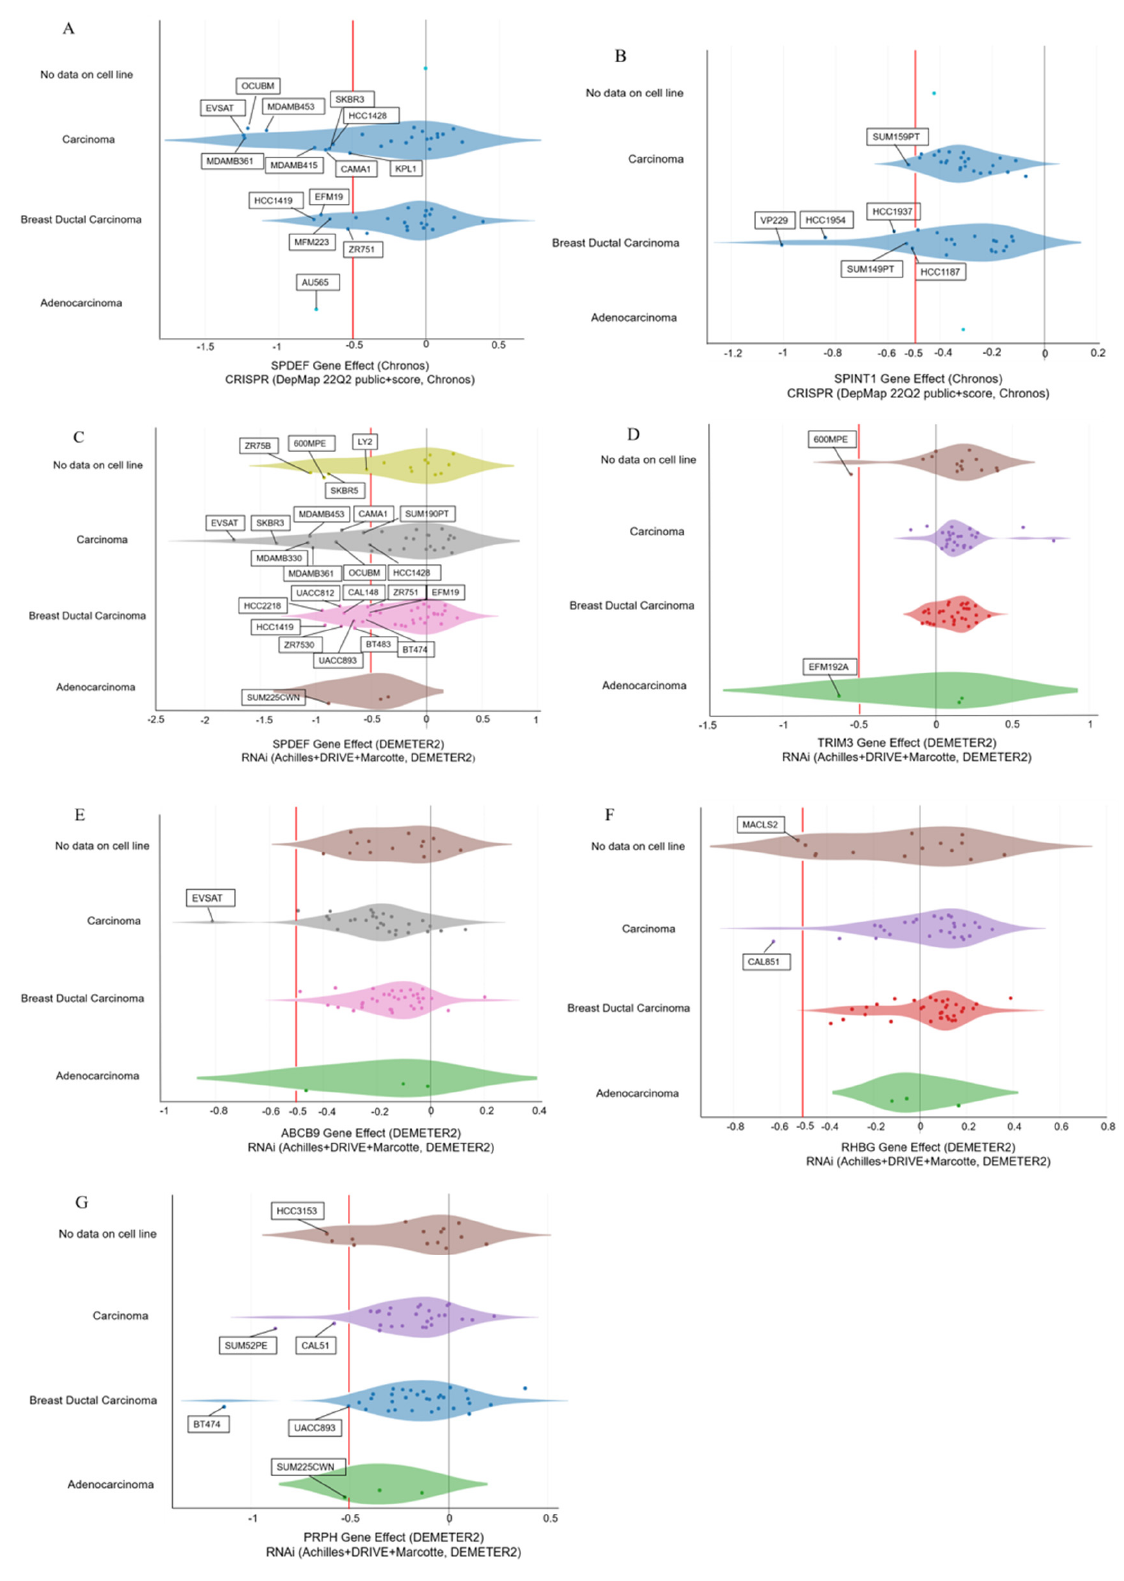
Figure 7. DepMap screening of candidate genes. Red line represents the cut-off value of − 0.5. CRISPR-Cas9 screening: ( A ) SPDEF and ( B ) SPINT1 . RNAi screening: ( C ) SPDEF , ( D ) TRIM3 , ( E ) ABCB9 , ( F ) RHBG , and ( G ) PRPH